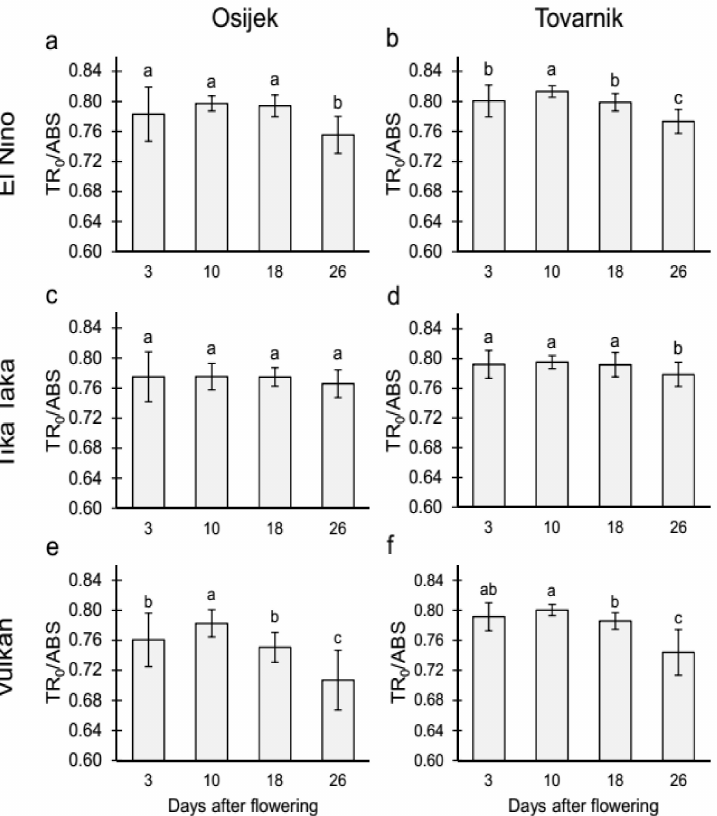
Figure 6. Maximum quantum yield of primary photochemistry (TRo/ABS) presented as mean value ± standard deviation of 20 wheat heads of variety El Nino ( a , b ), Tika Taka ( c , d ), and Vulkan ( e , f ) through four measurement points at two locations separately (Osijek and Tovarnik). Standard deviations are presented as vertical bars. Lower-case letters above columns are used to present results of statistical data analysis obtained by Fisher’s LSD test and point to statistically significant difference ( p < 0.05) between values of TRo/ABS measured at 3, 10, 18, and 26 days after flowering for each wheat variety separately and at each